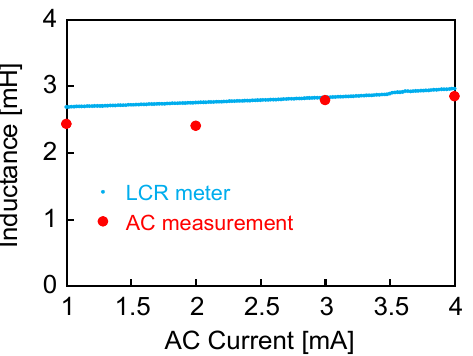
Figure 5. Inductance value under an AC current of small amplitude (without introducing any large Barkhausen jumps) applied to the circuit shown in Figure 3.